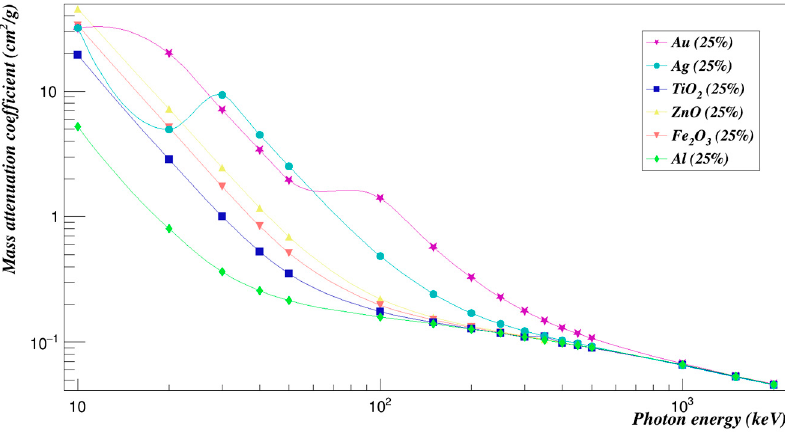
Figure 17. Mass attenuation coefficients of Polyimide doped with 25% of different composites.